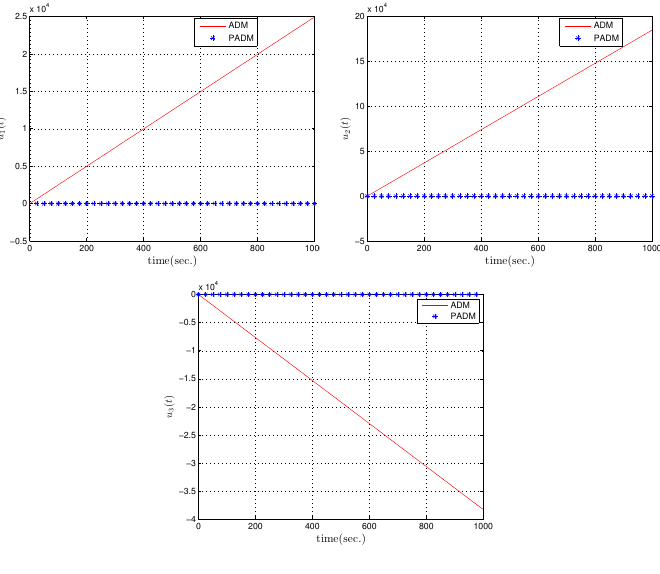
Figure 2. The ADM approximate ( M = 1, m = 20) and PADM solution ( M = 50, m = 2) of control functions.